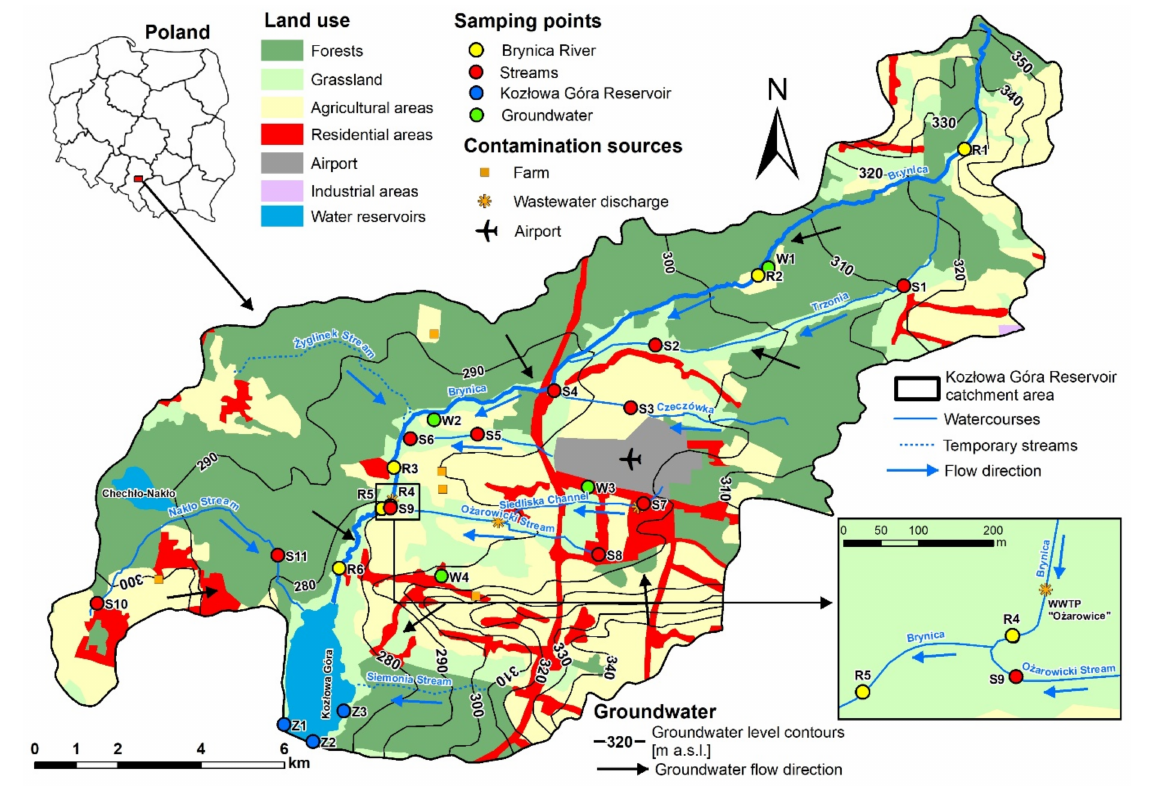
Figure 1. Land use and identified contamination sources within the Kozłowa G ó ra catchment area, based on